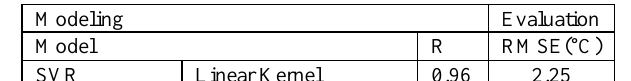
Figure 7. The best structure of the